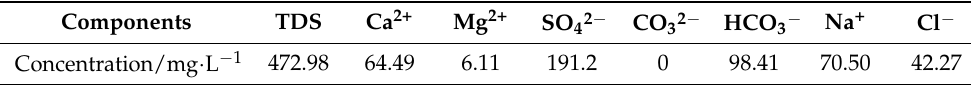
Table 1. Composition analysis of the formation brine.